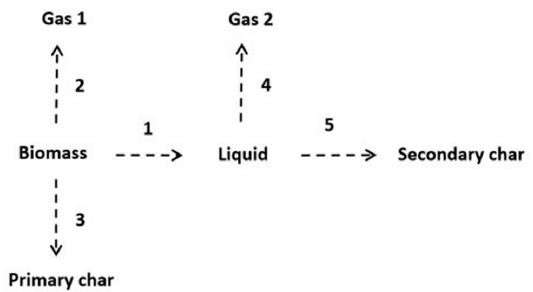
Figure 2. Simplified HTC reaction path used in the model [50].